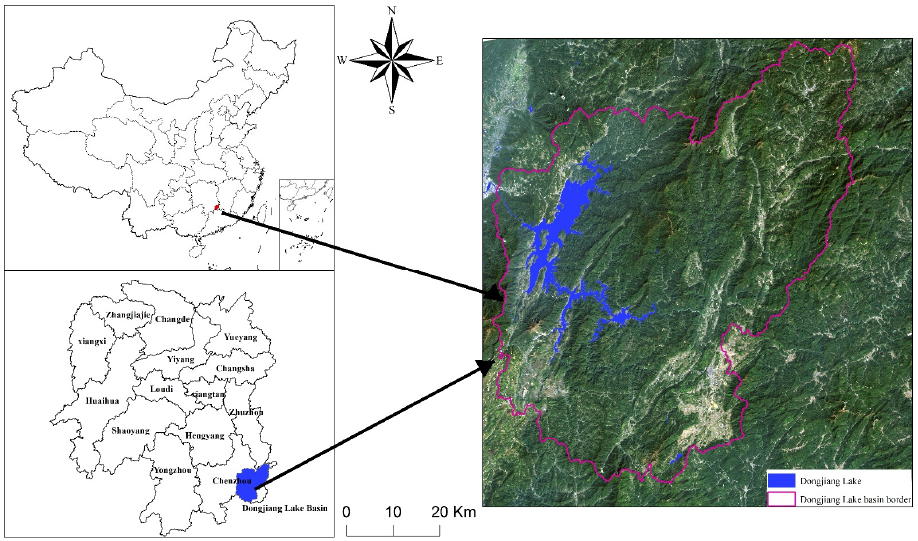
Figure 1. Location and boundary of the Dongjiang Lake Basin